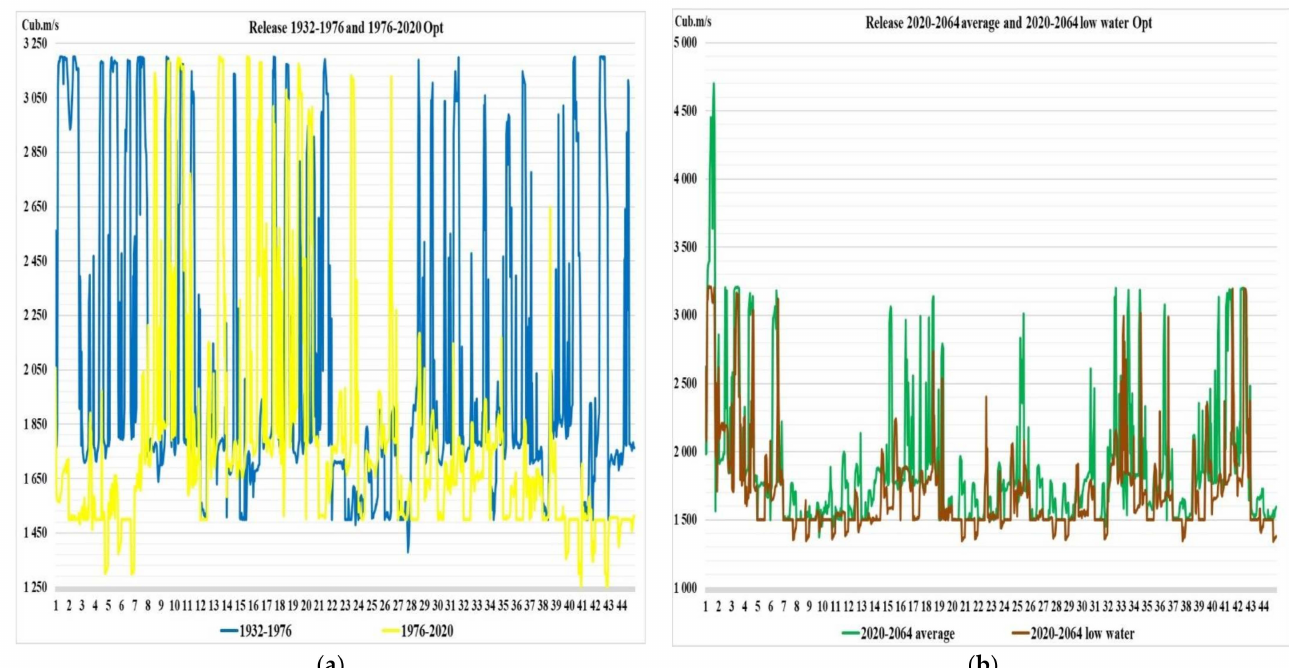
Figure 9. Releases to the Irkutsk reservoir downstream obtained as a result of WRC using optimization methods for